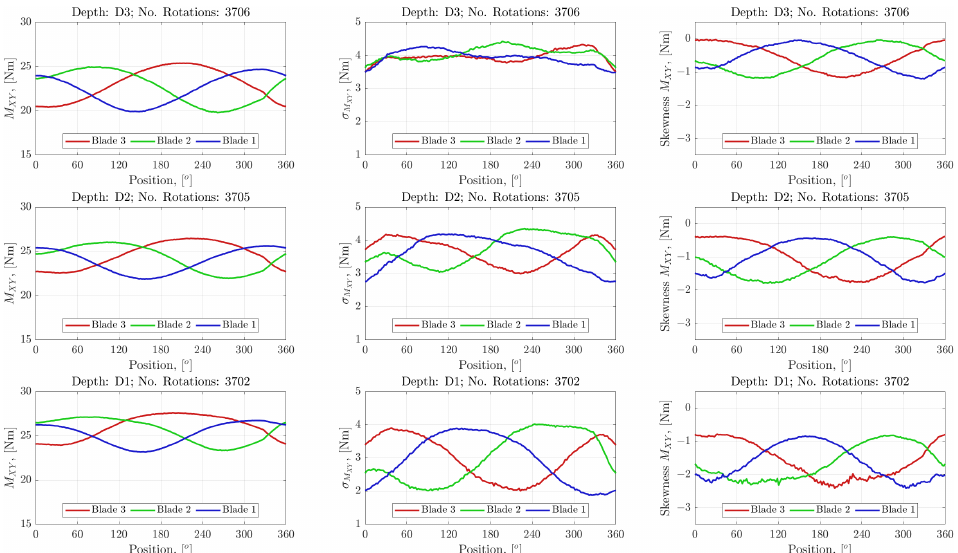
Figure 15. Plots showing the positional variation statistically of the out-of-plane BRBM measurements taken at differing submersion depths. Leftmost charts show mean BRBM, central charts show standard deviation and rightmost charts show skewness. Upper, middle and lower charts show submersion depths D3, D2 and D1, respectively. The data shown are for the CO